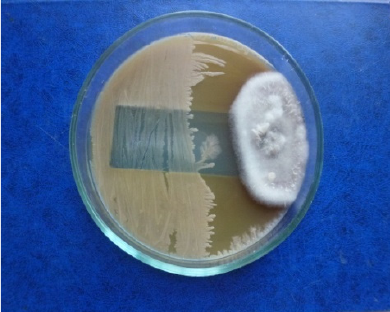
Figure 1. Method of double cultures with a glass slide for microscopy.